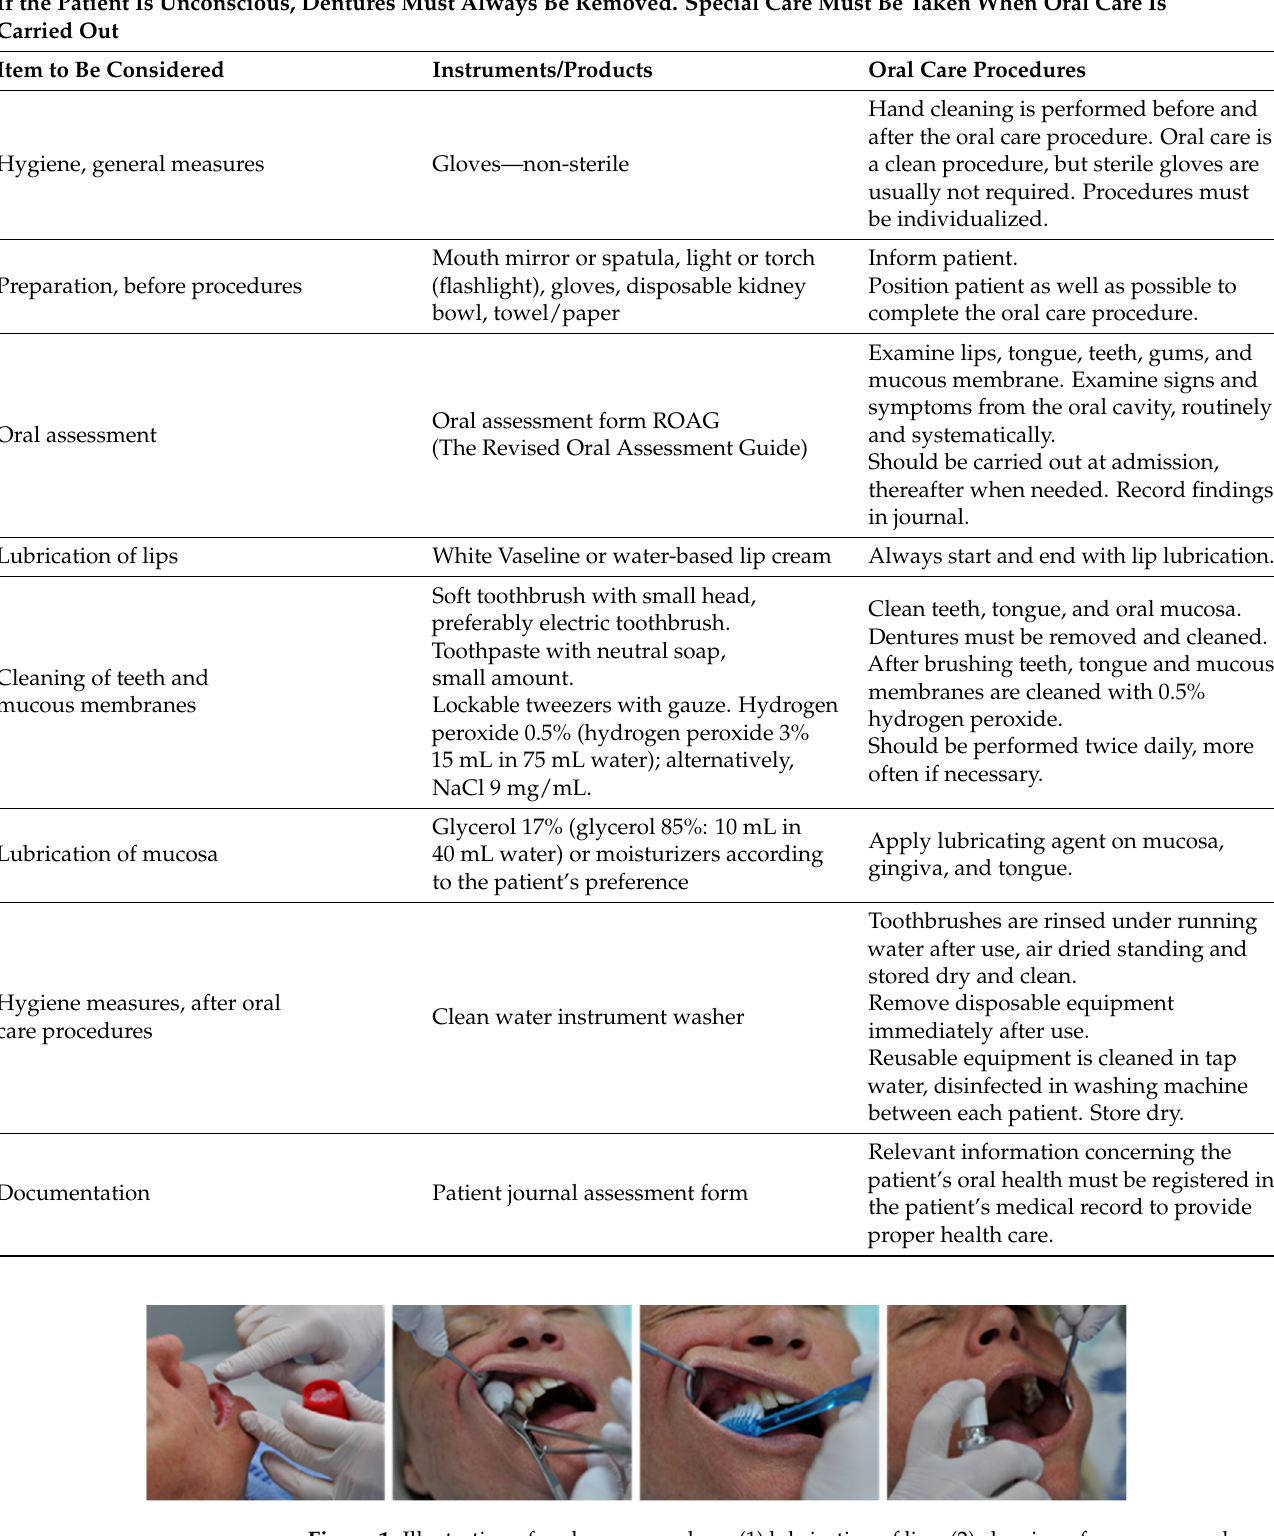
Table 1. Procedures for oral care in palliative patients, prepared by a group from the Regional Centre of Excellence for Palliative Care, Norway (translated into English by the authors of this article).